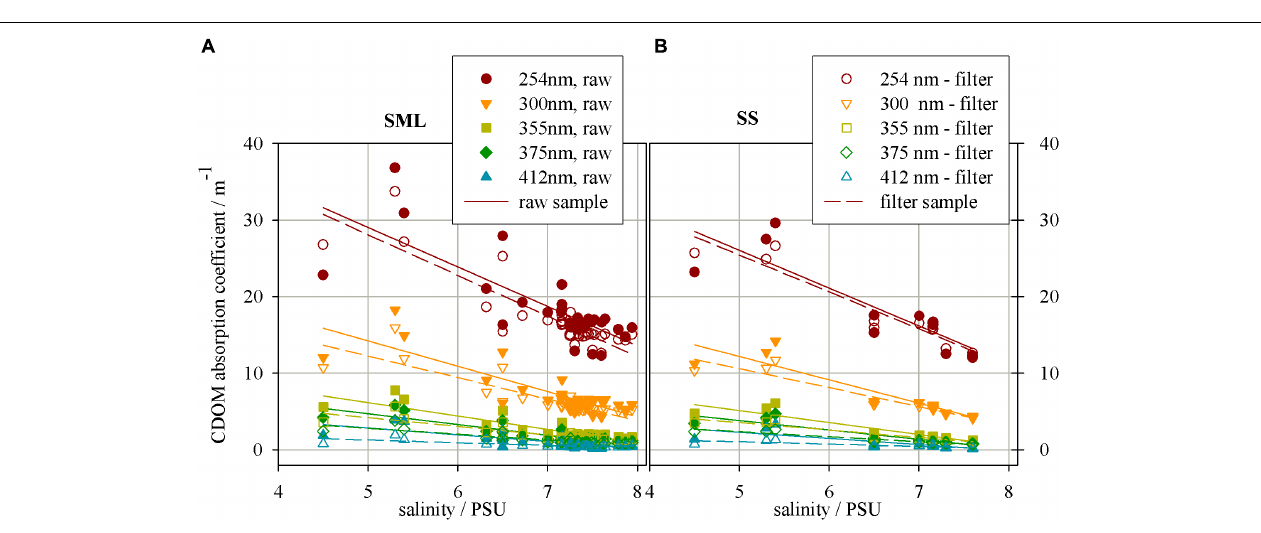
FIGURE 2 | The relation between salinity and CDOM absorption coefficient in different wavelength for the samples collected from (A) a surface microlayer (SML) and (B) a depth of 1 m (SS), for ‘raw’ and filtered